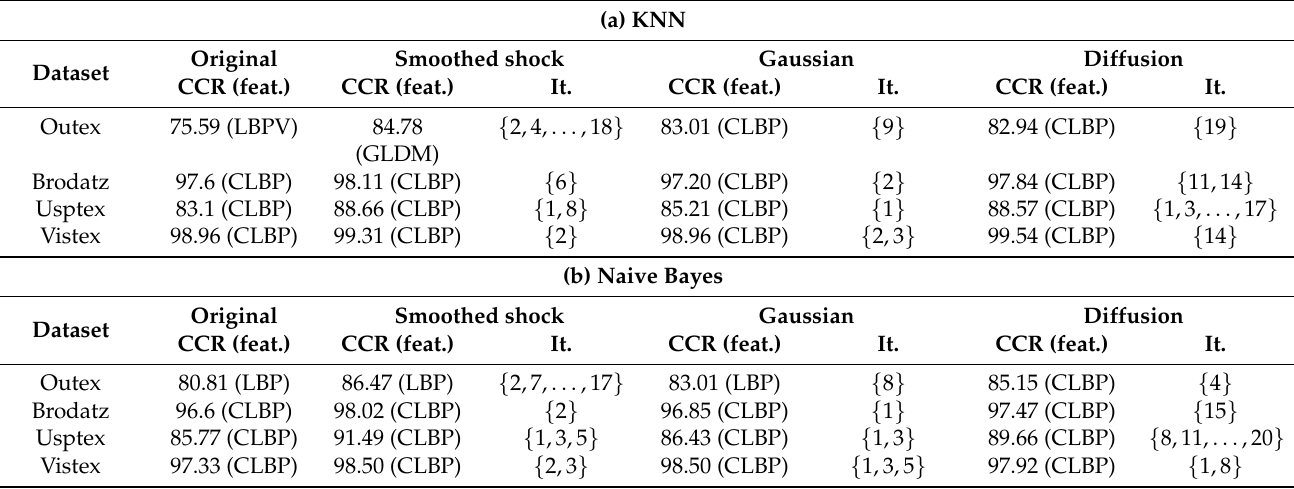
Table 3. Performance of classifiers, KNN ( a ) and Naive Bayes ( b ) approaches, for four texture classification datasets, by considering three pre-processing filters: smoothed shock filter, Gaussian filter, and anisotropic diffusion. For each filter, we present the best Correct Classification Rate (CCR), together with the feature and the combination of iterations leading to this rate. The leftmost column is the best rate without any